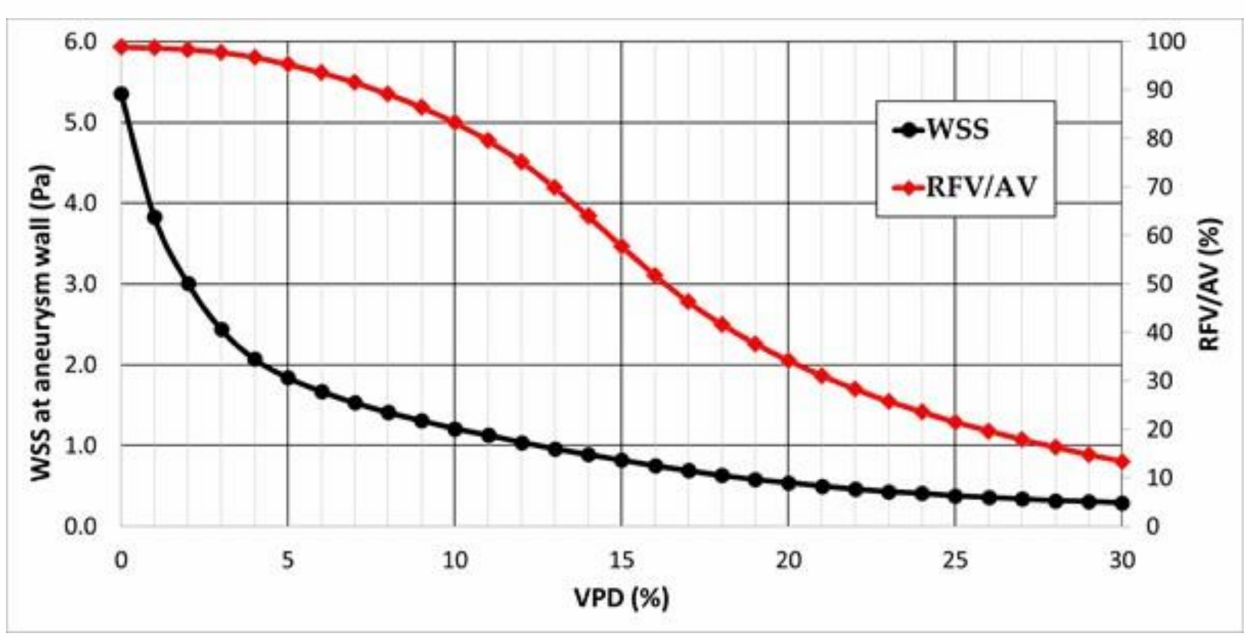
Figure 8. Area-averaged WSS at the aneurysm wall and residual flow volume (RFV)/aneurysm volume (AV) ratio values for each analysed VPD; stationary